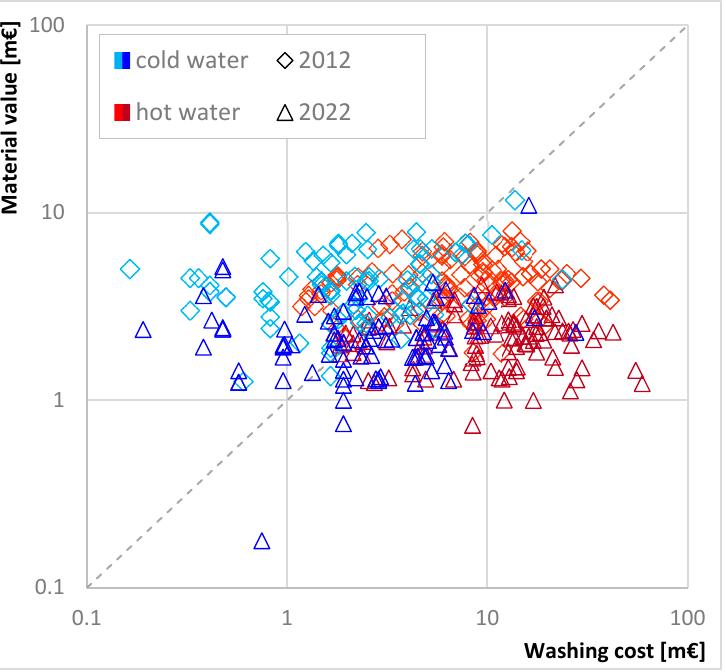
Figure 1. Comparison of the value of recyclable material and the cleaning cost for glass packaging.